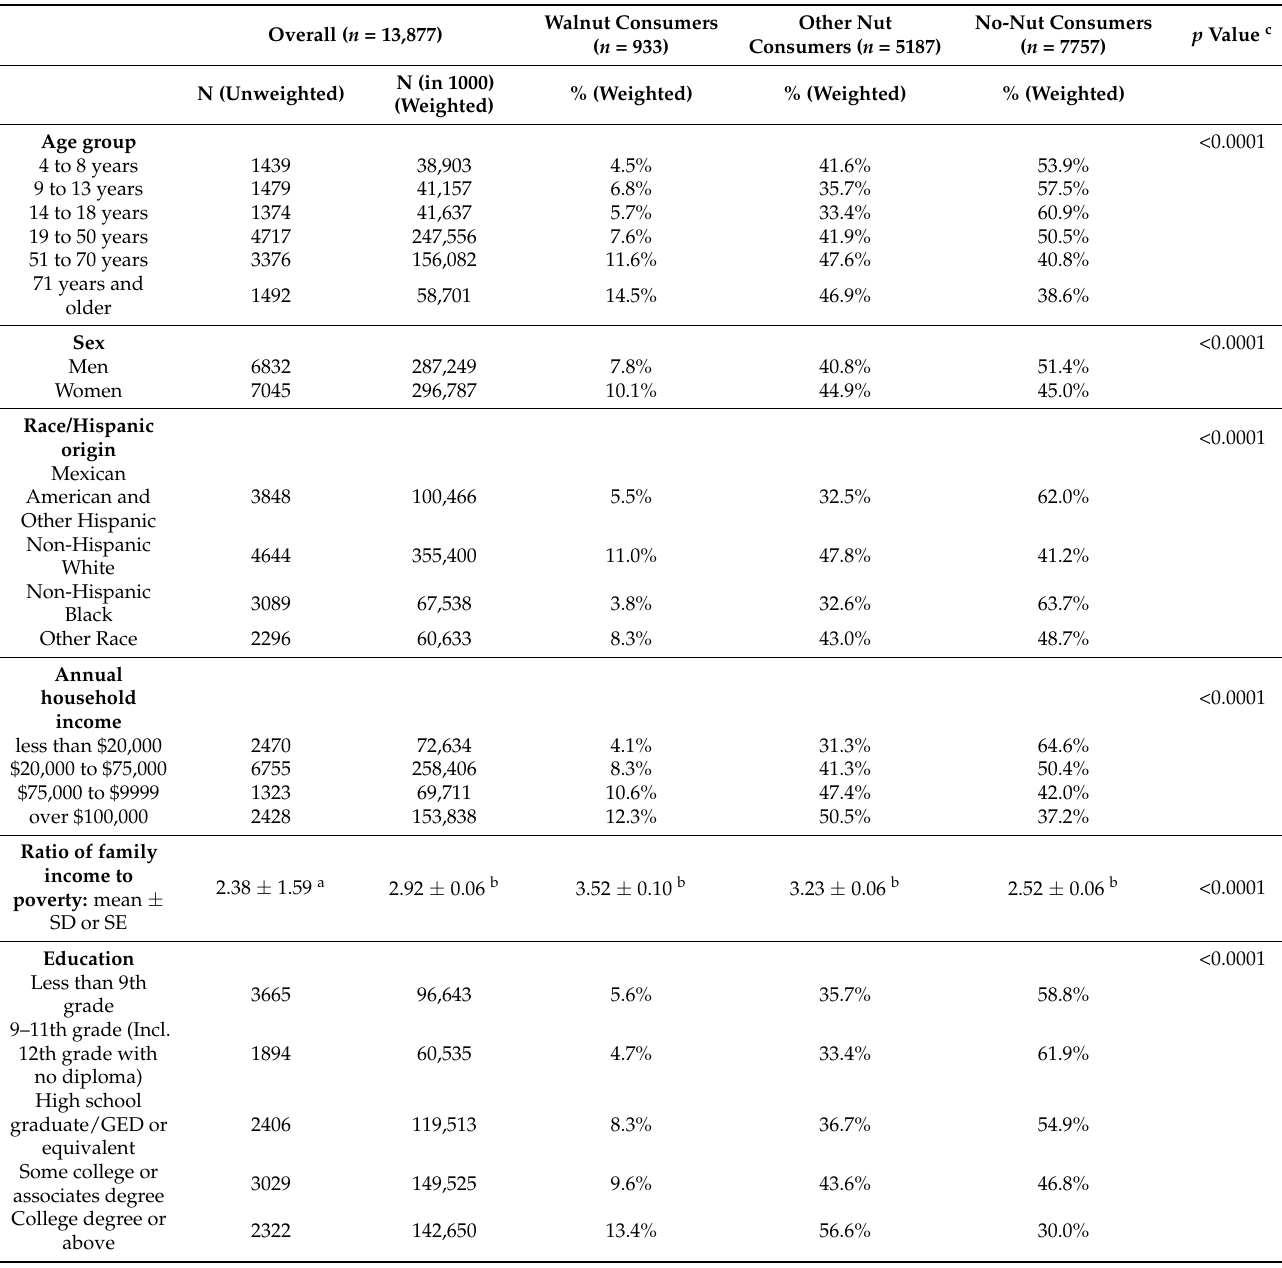
Table 1. Weighted demographic characteristics of National Health and Nutrition Examination